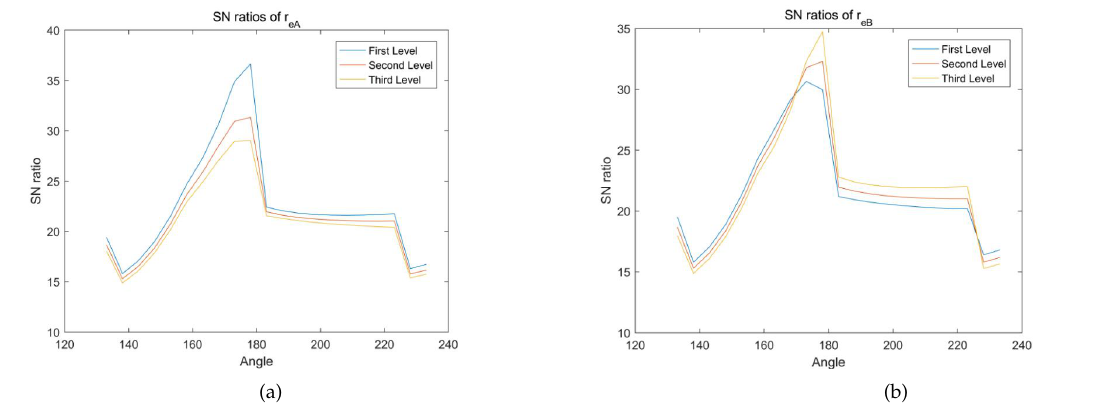
Figure 10. ( a ) The SN ratios of r eA ; ( b ) The SN ratios of r eB